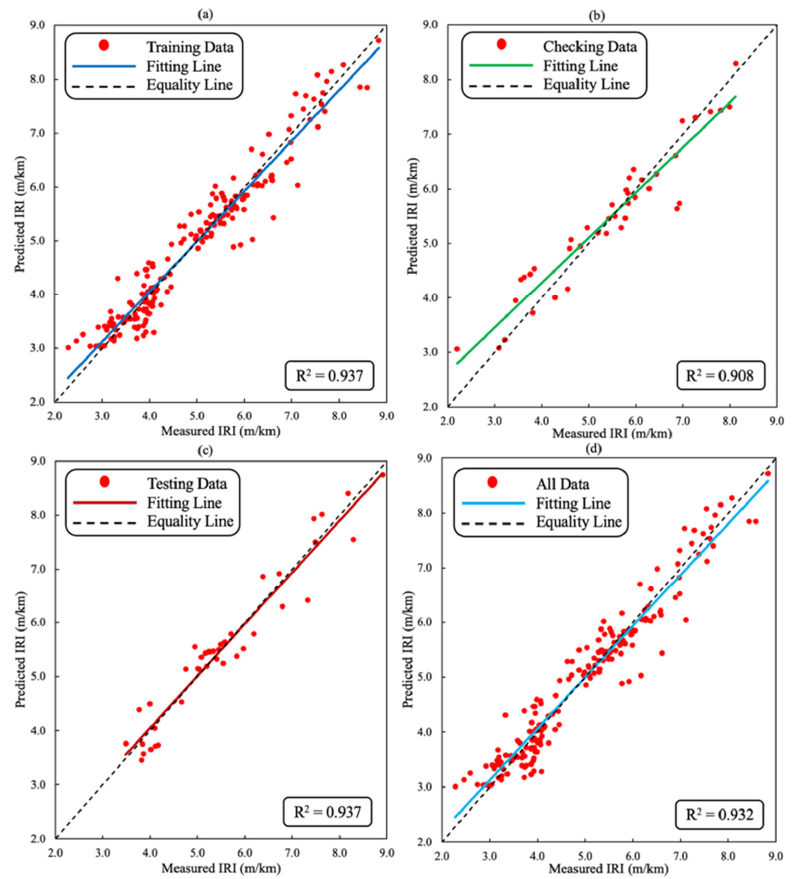
Figure 14. DBST regression analysis results between measured and predicted IRI values for the ( a ) training, ( b ) checking, ( c ) testing, and ( d ) all data.